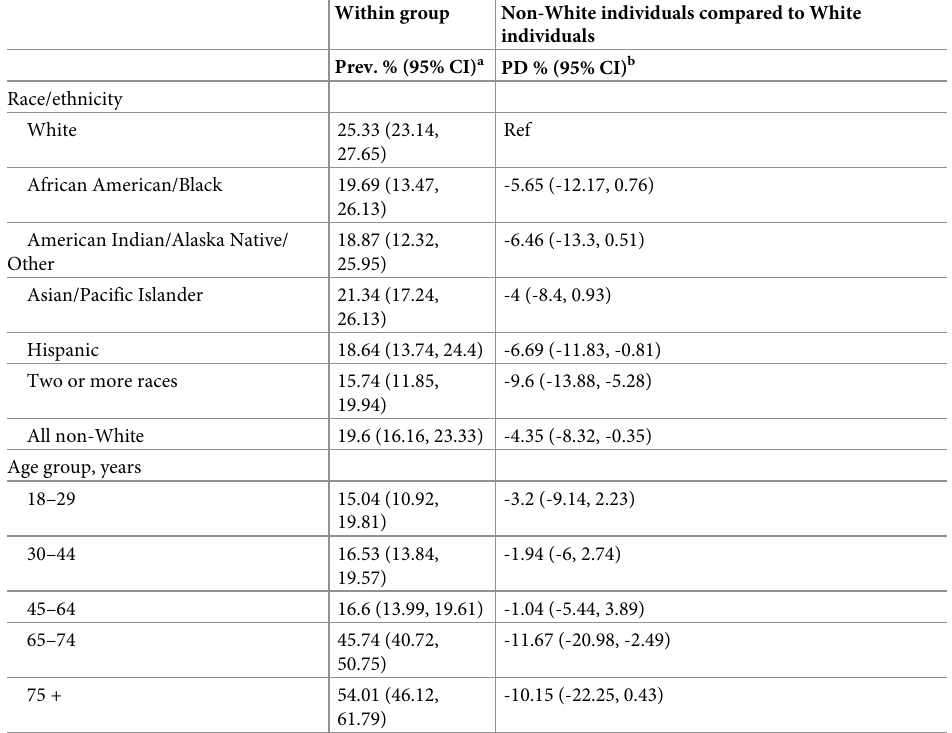
Table 4. Population-adjusted prevalence of antibodies from COVID-19 vaccination in Round 3 within race/eth- nicity and age groups and prevalence differences between non-White and White individuals. Within